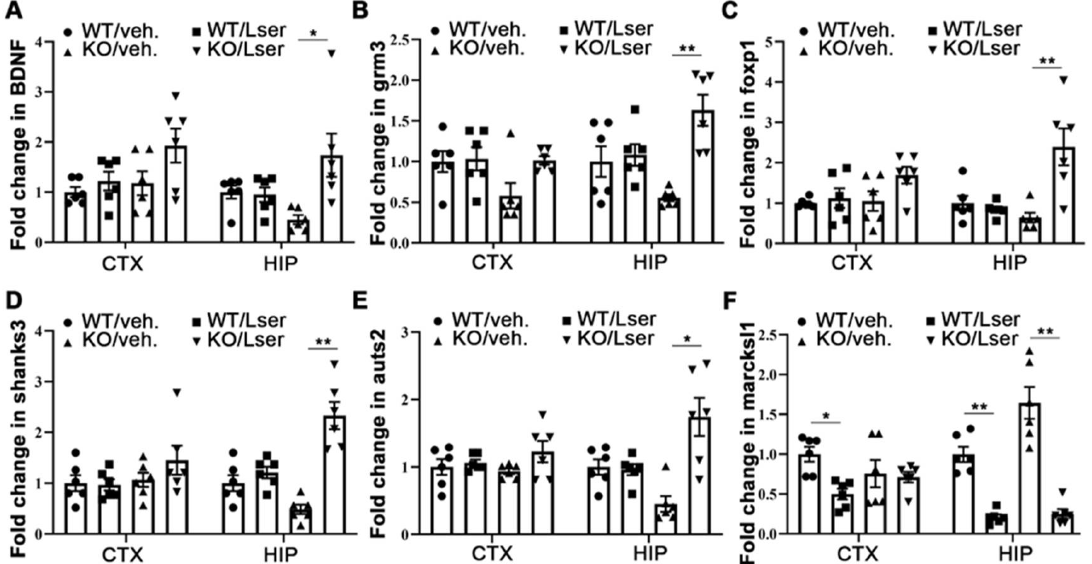
Figure 6. Oral administration of L-serine regulated gene expression in hippocampus and cerebral cortex of GHRH-KO mice and wild type controls. GHRH-KO mice and age-matched wild type controls were subject to L-serine oral administration for 12 weeks. The mice were euthanized and tissues (CTX, cerebral cortex and HIP, hippocampus) were collected for RNA extraction. ( A ) Expression of BDNF . ( B ) Expression of grm3 . ( C ) Expression of foxp1 . ( D ) Expression of shanks3 . ( E ) Expression of auts2 . ( F ) Expression of marcksl1 . n = 6 mice per group. Data represent means ± SEM. * p < 0.05, ** p < 0.01.